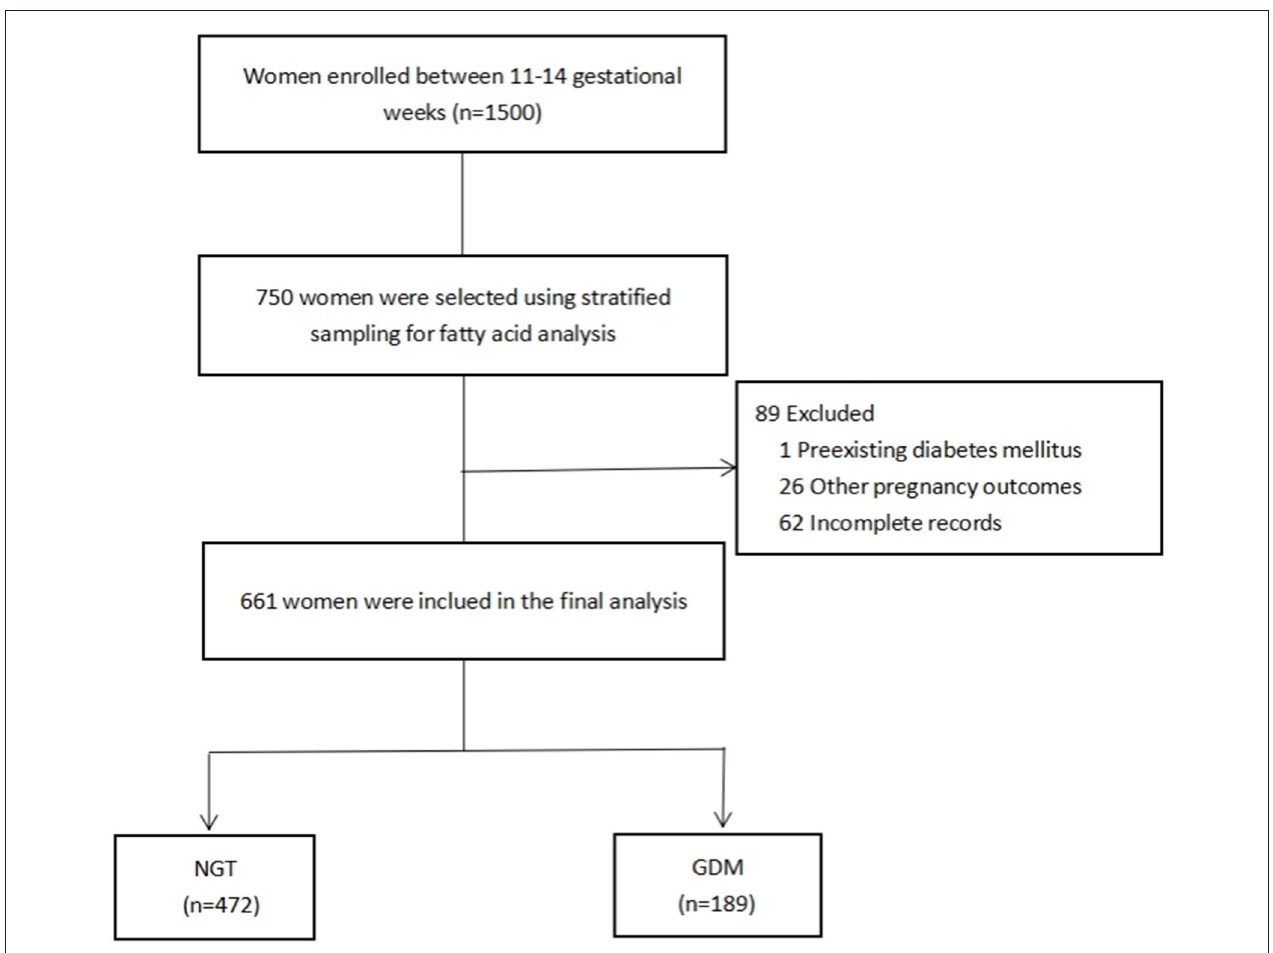
FIGURE 1 | Flowchart of the selection of study participants. NGT, normal glucose tolerance; GDM, gestational diabetes mellitus.